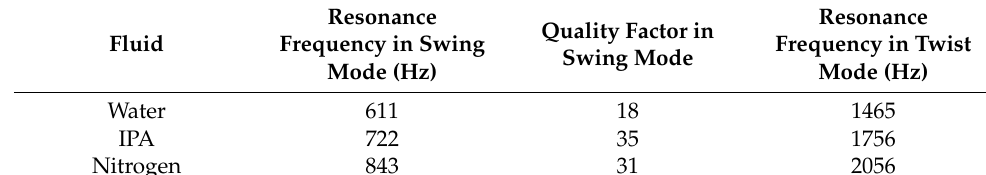
Table 3. Measured resonance frequencies in twist and swing mode, and the quality factor in swing mode. During flow measurements, the device is actuated in resonance in the twist mode. Coriolis forces due to mass flow will actuate the swing mode at the vibration frequency of the twist mode.